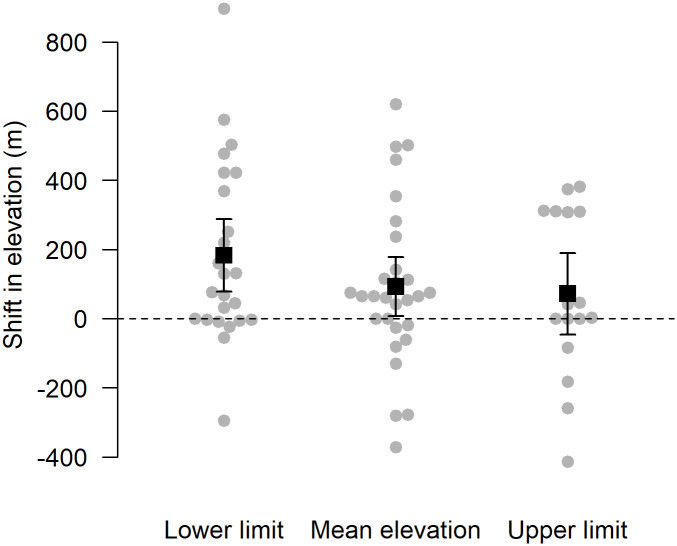
Shifts in mean elevation and lower and upper elevational range limits of 29 species of understory bird species between 1980 and 2019 in the Usambara Mountains, Tanzania.Elevational shifts were corrected for differences in elevation expected by chance. Each point represents a species. Black squares and bars represent the mean and 95% confidence intervals across species.